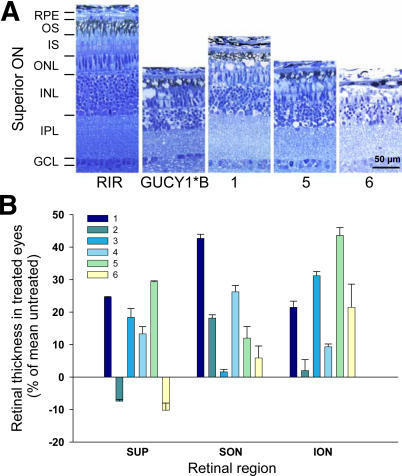
Comparison of Retinal Morphology of Wild-Type RIR, Untreated GUCY1*B, and Treated GUCY1*B Chickens(A) The morphology of the retinas of treated animals was examined to determine if the viral treatment had affected the course of retinal degeneration. Regions were analyzed along the vertical meridian of the right eyes of experimental and control animals; representative micrographs from the locus superior to the optic nerve (SUP ON) are shown from one wild-type, one untreated GUCY1*B, and three treated retinas (animals 1, 5, and 6). GCL, ganglion cell layer; INL, inner nuclear layer; IPL, inner plexiform layer; IS, inner segments; ONL, outer nuclear layer; OS, outer segments; RPE, retinal pigment epithelium.(B) Relative percent change in retinal thickness of treated animals. Retinal width (in micrometers) from the outer limiting membrane to the ganglion cell layer was measured at six loci (100 μm apart) within the regions examined. These widths were expressed as percent change relative to average widths of the untreated GUCY1*B retinas in these regions, which were set to zero for graphing purposes. A simple one-sample t-test (null hypothesis that treatment groups are not different from untreated GUCY1*B) was used to analyze the results. The results of this test showed that retinal thicknesses of the treated animals in the SUP ON (SON) and INF ON (ION) regions were greater than those of untreated animals (p < 0.05). Four of six treated animals also showed evidence of slowing of degeneration in the SUP region, but this was not statistically significant. The key for animal number is shown in the upper left of the graph.